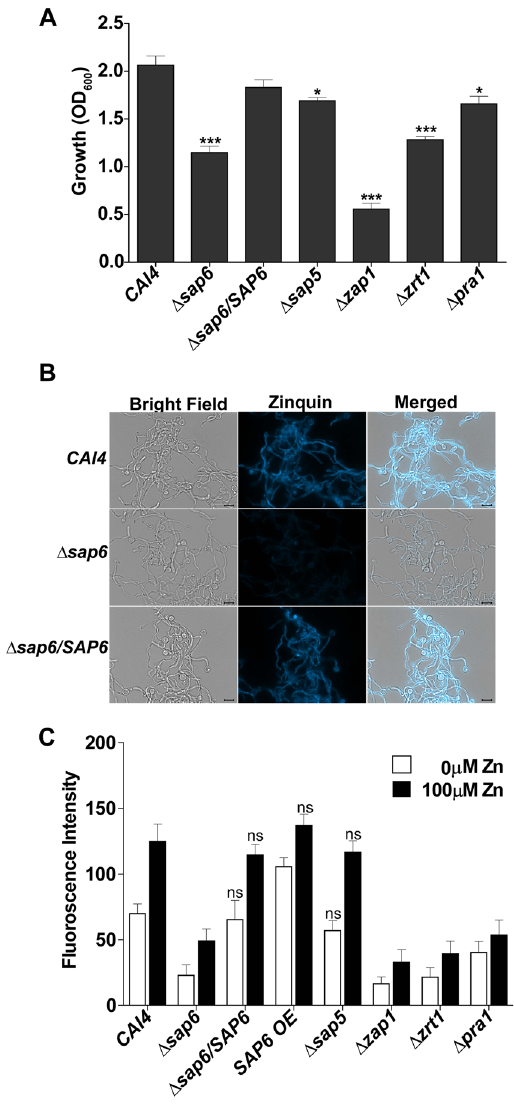
Figure 7. C . albicans Sap6 deletion results in defective growth in low zinc medium and reduced intracellular zinc accumulation. ( A ) C . albicans CAI4 and Δ zap1 , Δ pra1 , Δ zrt1 , Δ sap5 , Δ sap6 , Δ sap6 / SAP6 and SAP6O/E cells were inoculated into Low Zinc Medium (LZM) with initial OD 600 = 0.01, grown for 24 h at 30 °C, and growth measured at OD 600 . C . albicans Δ zap1 cells had the largest reduction in growth followed by Δ zrt1 and Δ sap6 . Data are averages of three independent experiments. ( B ) CAI4, Δ sap6 and Δ sap6 / SAP6 were grown overnight in LZM, germinated, fixed with paraformaldehyde, and stained with Zinquin (25 µ M). Accumulation of intracellular zinc was measured by relative intensity of Zinquin staining. C . albicans Δ sap6 strain had decreased Zinquin compared to CAI4 which was reversed upon Δ sap6 / SAP6 complementation. ( C ) Cells were grown overnight in LZM, germinated in the presence of 100 µ M ZnCl 2 (black bars) or without added zinc (white bars), and relative intensity of Zinquin fluorescence in hyphal cells measured. C . albicans Δ zap1 , Δ pra1 , Δ zrt1 and Δ sap6 all had significantly (P < 0.001) lower Zinquin staining with or without added zinc compared to CAI4. In contrast, SAP6 O/E strain had a significant (P < 0.05) increase in Zinquin staining only in low zinc conditions, while the Sap6 revertant ( Δ sap6 / SAP6 ) and Δ sap5 cells were not significantly different than WT cells. Values are mean ± SD of three independent